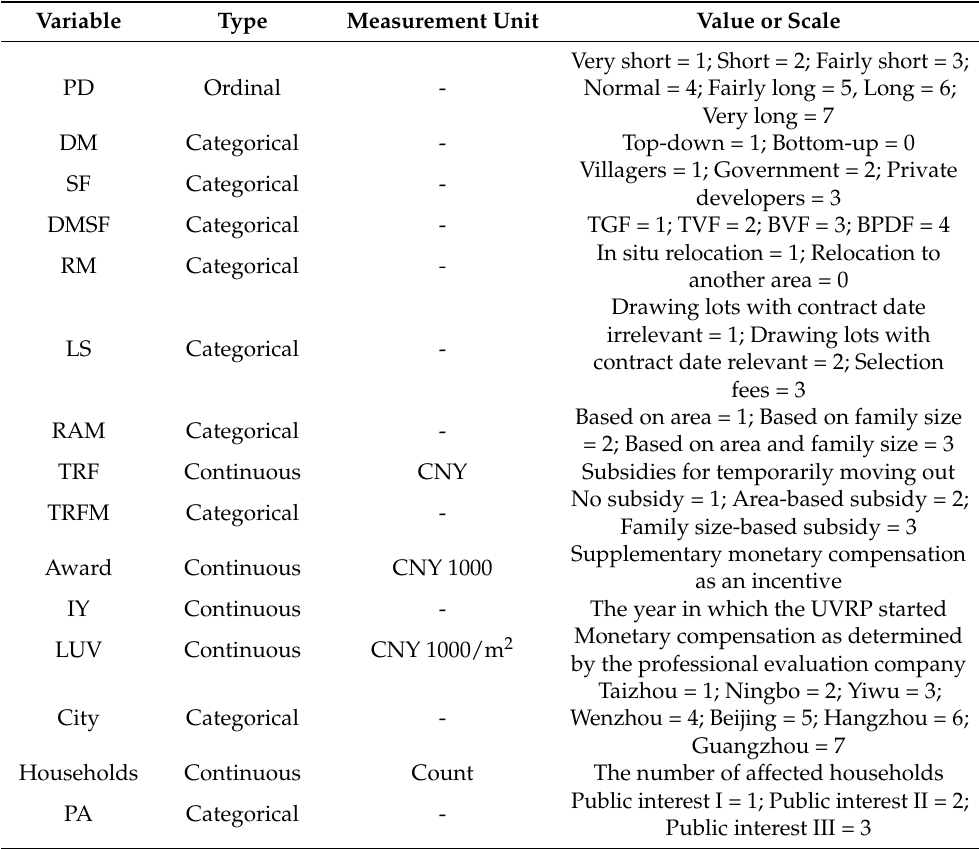
Table 3. Measurement of